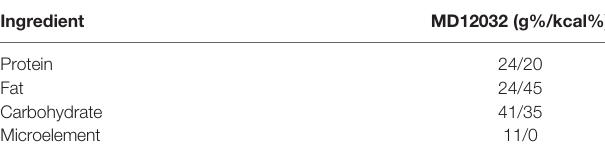
TABLE 6 | Components of high fat diet. Ingredient